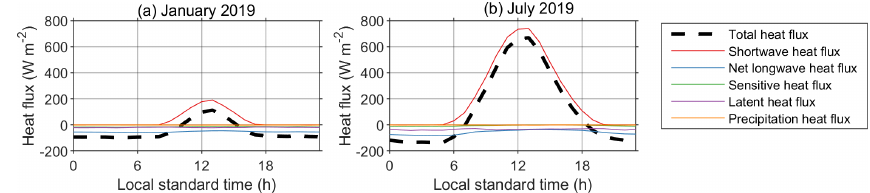
Figure 5. Modeled mean diurnal variations in the heat flux at the surface of Lake 12 for January (a) and July 2019 (b)